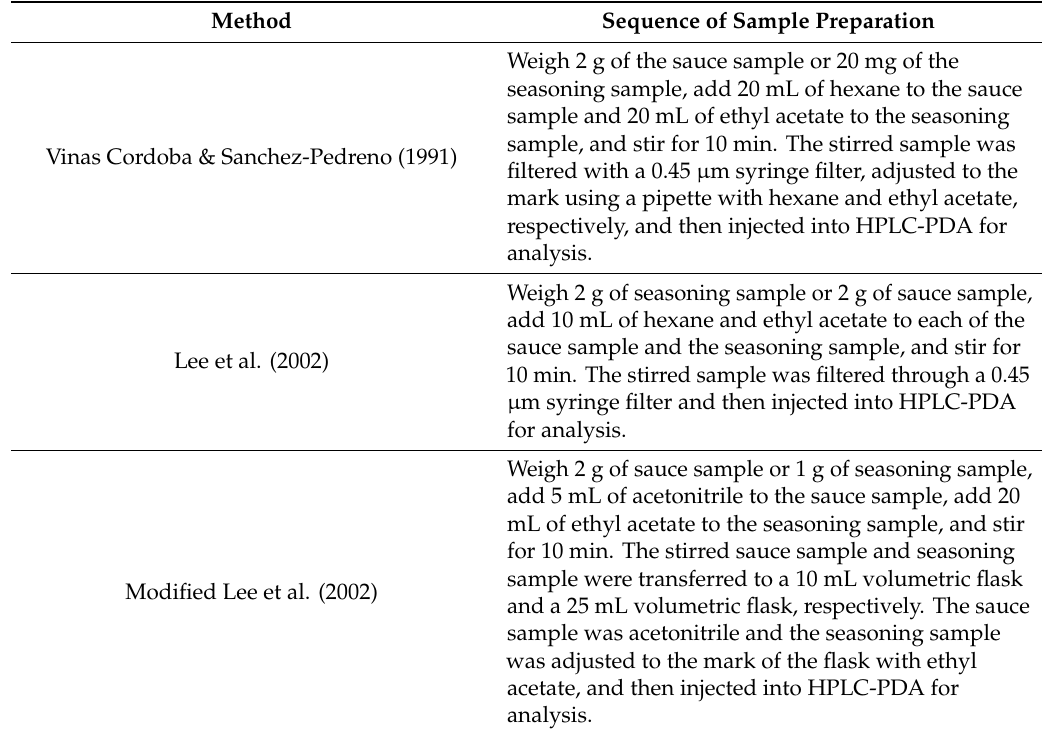
Table 1. The original sample preparation method and the modified sample preparation